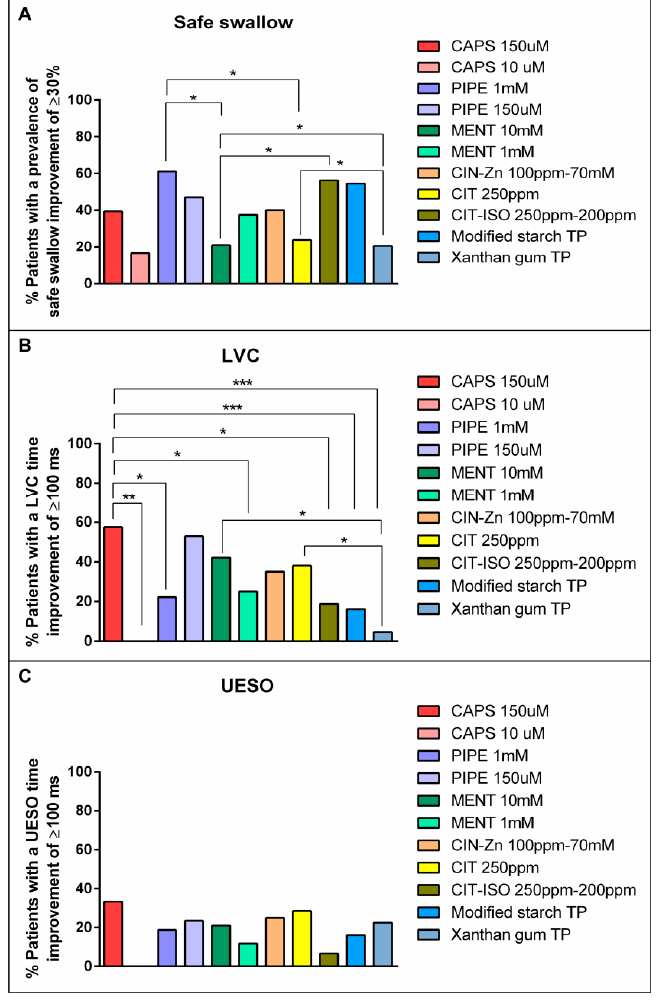
Figure 5. Graphical representation of percentage of patients that increased safe swallows at least 30% ( A ), reduced time to of LVC by 100 ms ( B ) and time to UESO by 100 ms ( C ). CAPS: capsaicin; PIPE: piperine; MENT: menthol; CIN-Zn: cinnamaldehyde-zinc; CIT: citral; CIT-ISO: citral-isopulegol; TP: thickening product; LVC: laryngeal vestibule closure; UESO: upper esophageal sphincter opening; *: p < 0.05; **: p < 0.01; ***: p < 0.001.